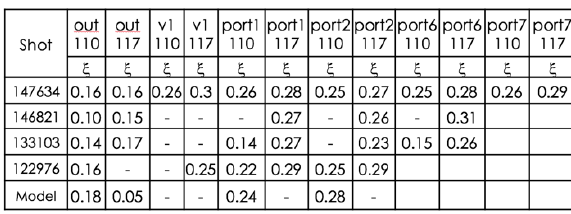
Table 2: Sample of peak ECCD efficiency from LFS vs